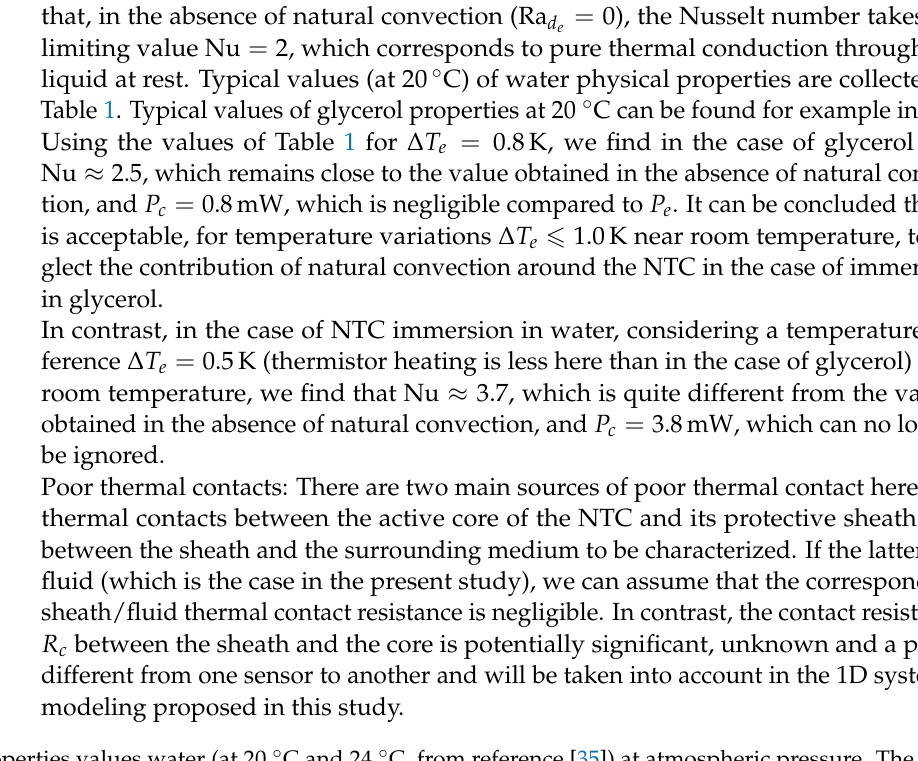
Table 1. Typical physical properties values water (at 20 ◦ C and 24 ◦ C, from reference [35]) at atmospheric pressure. The units of α and β are given in the